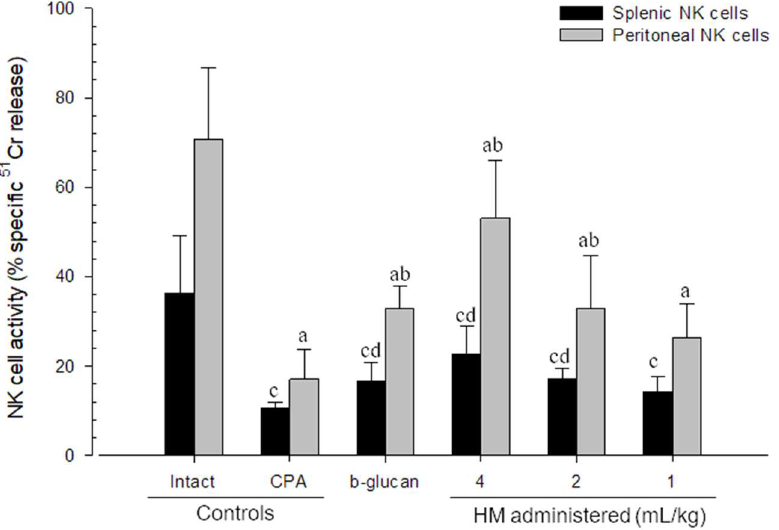
Figure 2. NK cell activities in response to hemomine treatment in intact or CPA-induced immuno- suppressed mice. The results are expressed as the means ± SDs (n = 10). NK: Natural killer, CPA: Cyclophosphamide, HM: Hemomine (60% LJG305). Different letters above bars indicate a significant difference at the p < 0.05 level compared with the a intact control and b CPA-treated control mice, as determined using the LSD test, and with the c intact control and d CPA-treated control mice using the Mann–Whitney test.